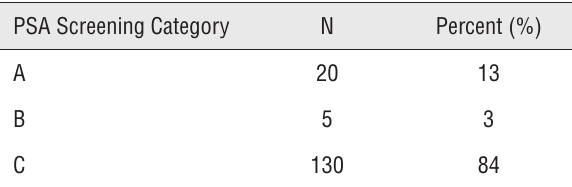
Table 3 - PsA screening category. PSA Screening